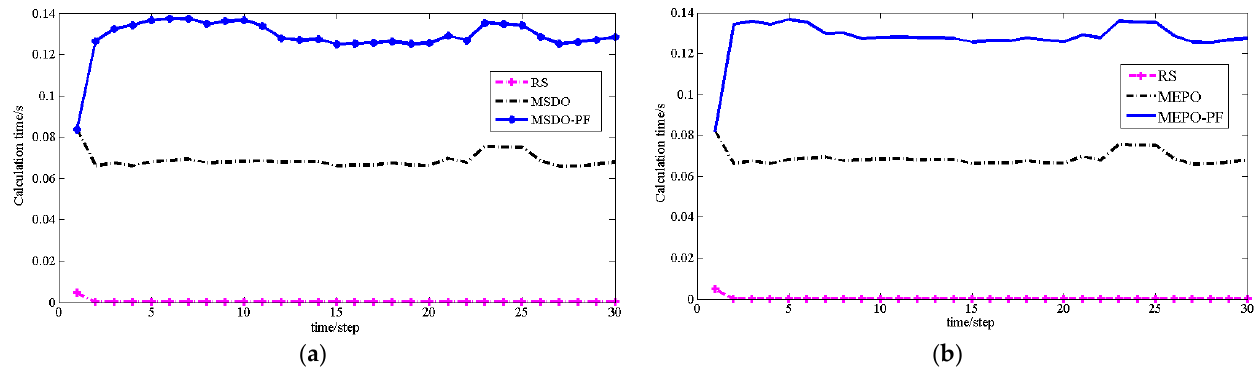
Figure 9. ( a ) T he calculation time of MSDO using PF or not ( b ) The calculation time of MEPO using PF or not. Table 8. Comparison of the positioning simulation